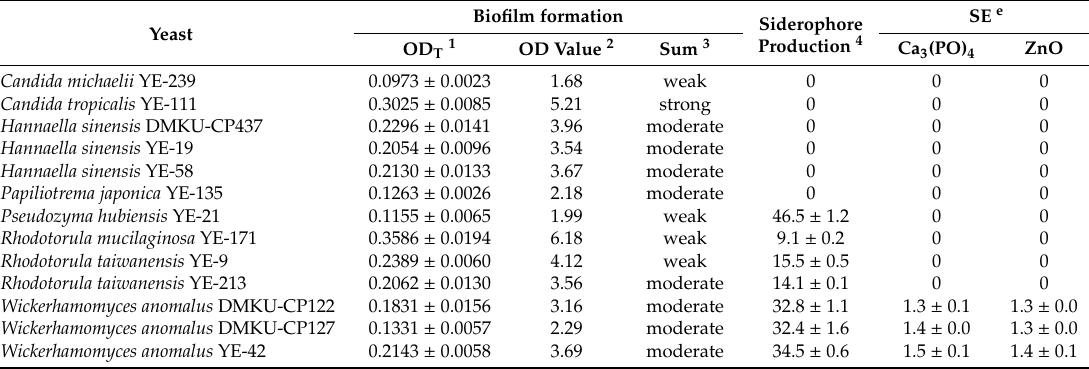
Table 3. Biofilm formation, siderophore production, and solubilization of zinc oxide and phosphate by antagonistic yeasts.